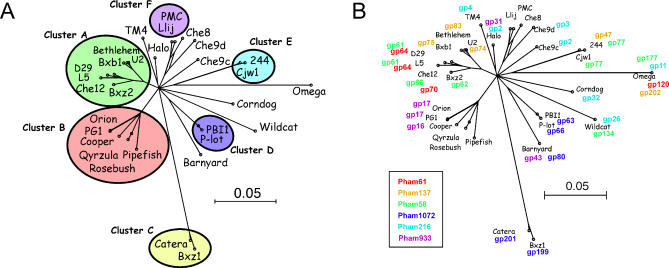
Representation of Mycobacteriophage Clusters Using Splitstree(A) The relationships between 30 mycobacteriophages are represented by Splitstree representation of a dataset in which each of the 1,536 gene phamilies is annotated as being either present or absent in each of the 30 genomes. Clusters A through F of genomes that are more closely-related to each other than to other mycobacteriophages are shown by colored circles.(B) The distribution of the members of six phamilies on the Splitstree representation in (A) illustrates that individual phamilies have notably different evolutionary histories than the aggregate representation.